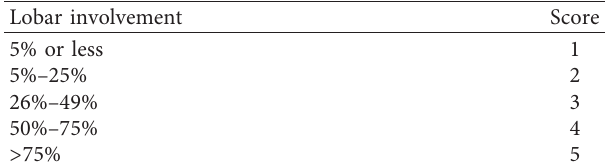
Table 1: Individual lobar scores based on percentage of involvement.